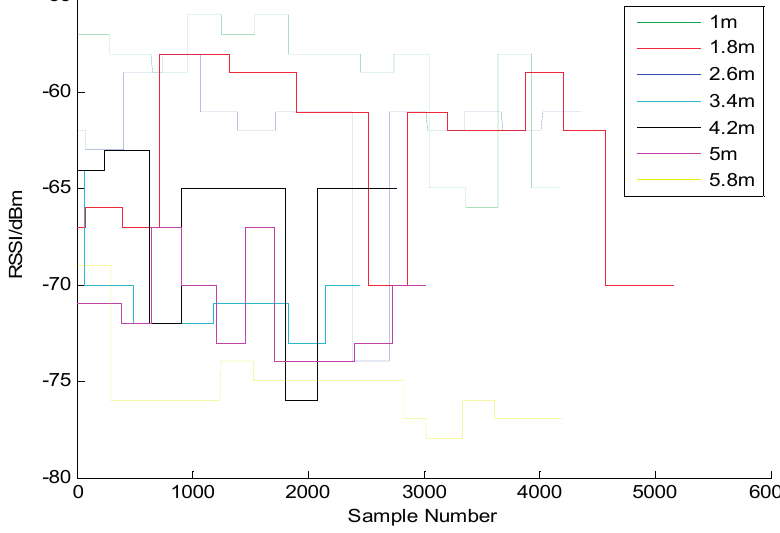
Figure 1. Changes in the field intensity of the beacon every 0.8 m.